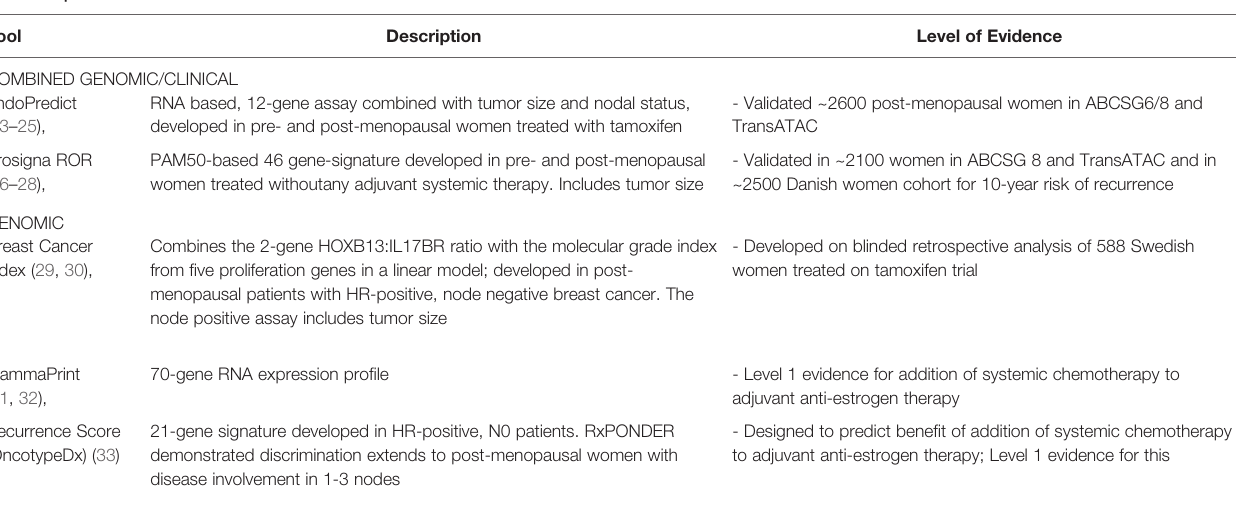
TABLE 2 | Genomic risk assessment